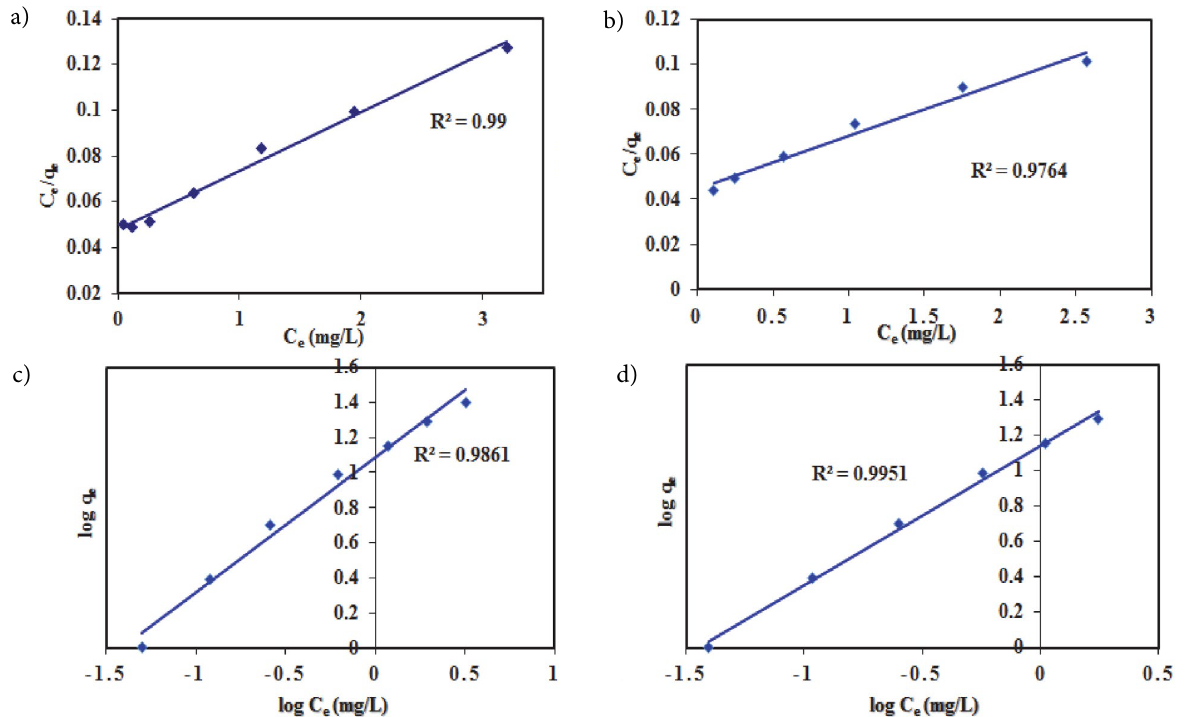
Figure 5. Langmuir adsorption isotherm of MB (a) and MO (b) and Freundlich isotherms of MB (c) and MO (d) (experimental condition: MB/MO concentrations = 5, 10, 20, 30, 40, and 50 mg/L, adsorbent dose = 2 g /L, pH = 8 for MB and pH 6 for MO, temperature = 25 o C).